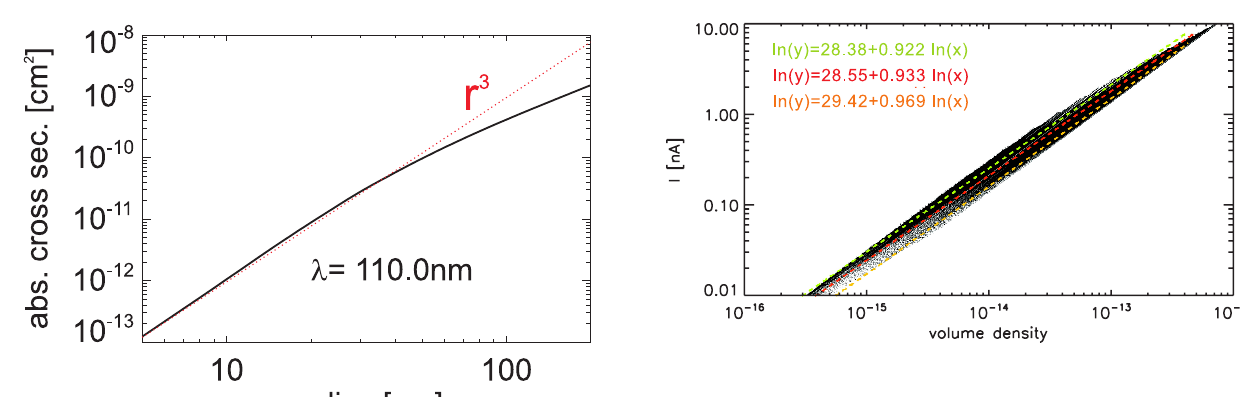
Fig. 8. Theoretically expected photoelectron currents to be detected by the ECOMA particle detector as a function of ice particle volume density (in cm 3 /cm 3 ). Each black point corresponds to one calcu- lation assuming either a Gaussian or lognormal size distribution for a large number of distribution parameters (see text for details). The colored dashed lines show fits of ln(current) versus ln(volume den- sity). The red line shows the best fit to the data, and the yellow and green lines indicate corresponding standard